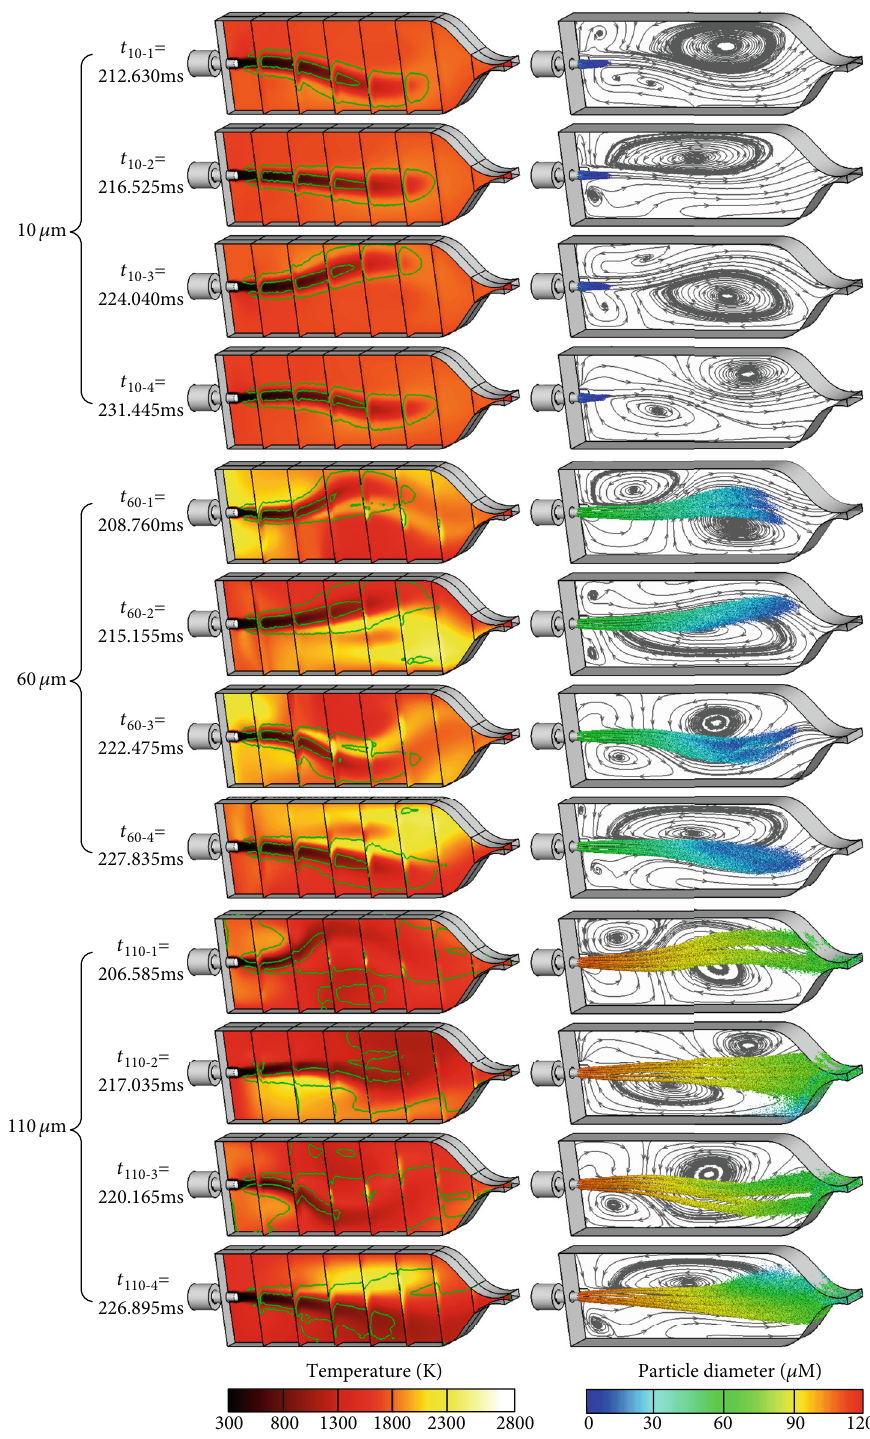
Figure 16: Evolution of the combustion fl ow fi eld for di ff erent initial LOX particle diameters in one period of pressure oscillation: the left column shows the cycle snapshots of the temperature distribution and the reaction region surrounded by green lines; the right column shows the streamline in the z = 0 plane and the distribution of LOX particles; all the time points are marked in Figure